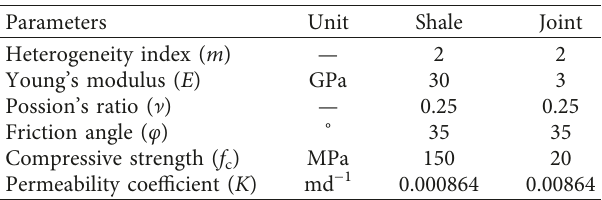
Figure 13: Fracture propagation in the numerical and experimental [38] results of the shale model. (a) Numerical results. (b) Experimental results. Table 2: Physicomechanical parameters of shale and joint employed in